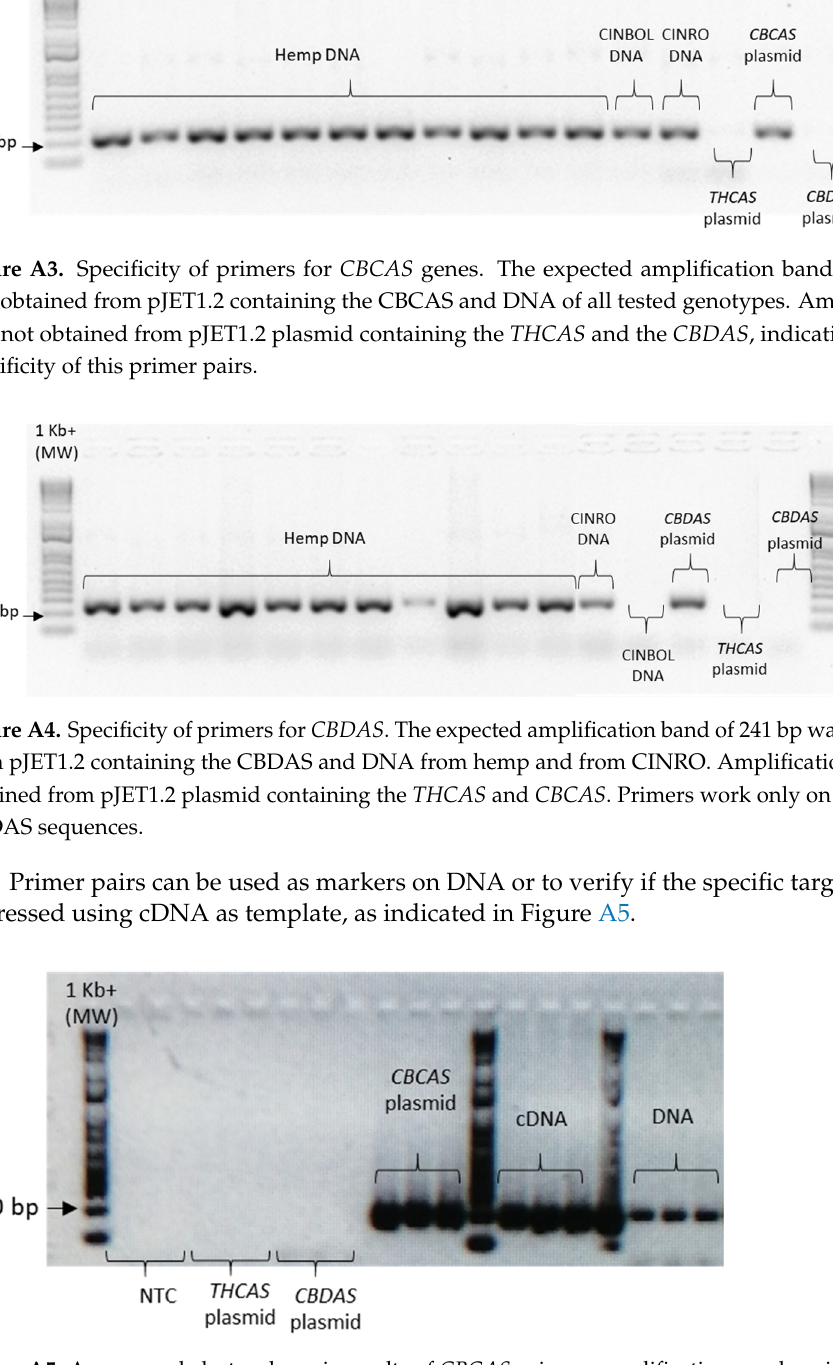
Figure A5. Agarose gel electrophoresis results of CBCAS primers amplification on plasmids con- taining each cannabinoid synthases, genomic DNA and cDNA of a hemp plant in triplicate. The PCR assays contained also 2 negative controls, where water was added instead of template (lane 1 and 2).